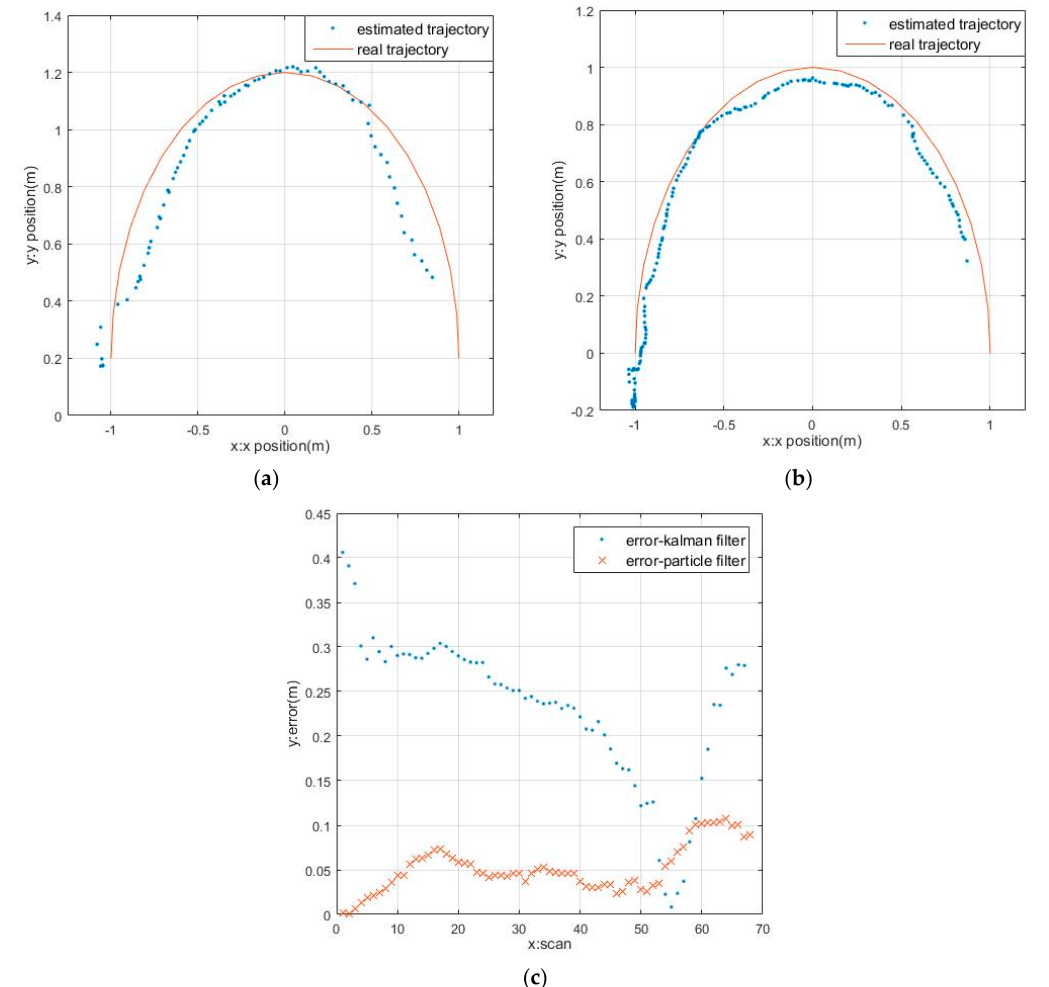
Figure 17. The tracking results in curvilinear motion: ( a ) Results with KF; ( b ) Results with adaptive PF; ( c ) The error of KF and PF.